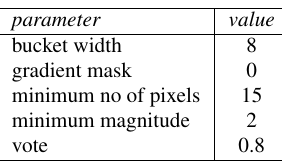
Table 2: Parameters of straight line extracting algorithm wire frame edges to their edge lines for another one. The